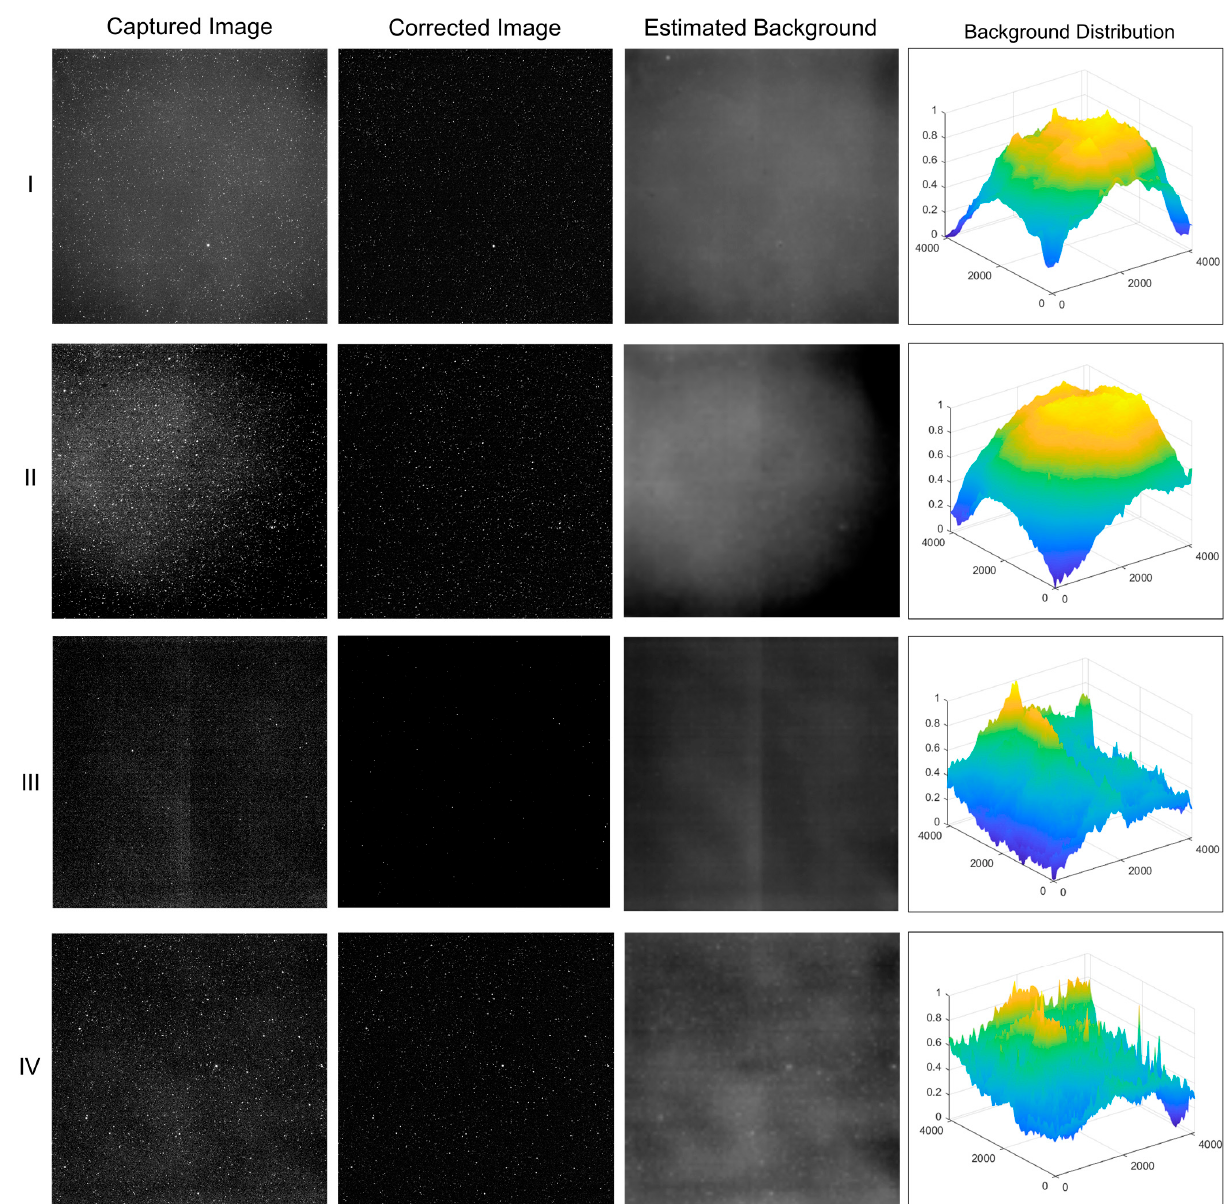
Figure 5. Correction results on images captured with the image acquisition equipment mentioned in Section 2.1. I–IV show di ff erent images.